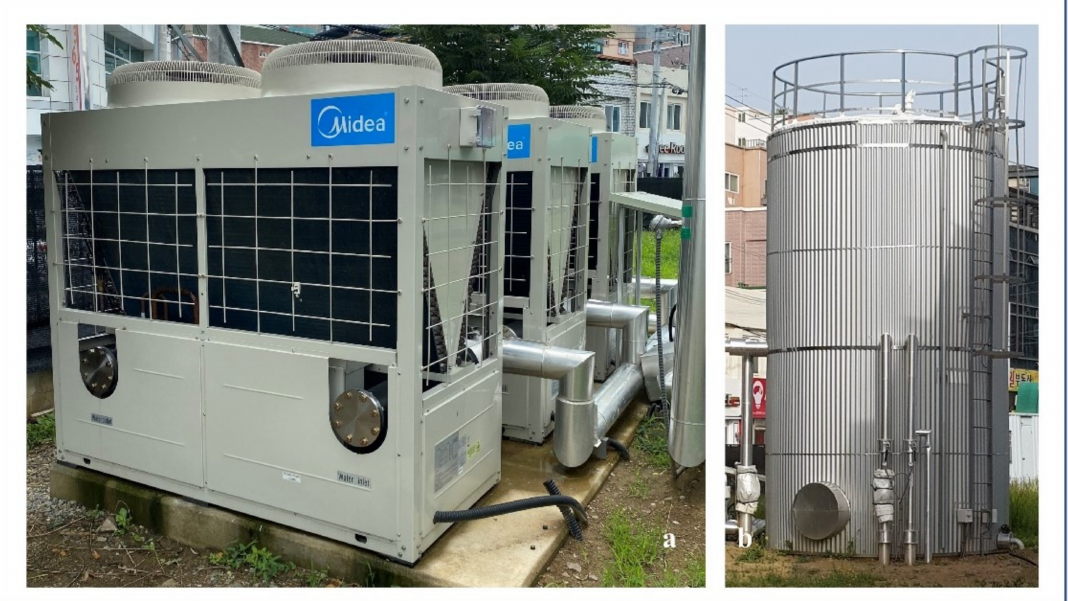
Figure 4. Field picture of ( a ) AWHP and ( b ) water storage tank.